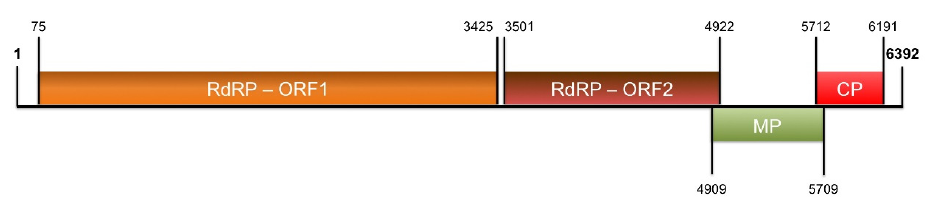
Figure 3. Sequencing analysis using ONT MinION. A graphical representation of the genome organization of ToBRFV isolate Tom-BA21. RdRp: RNA-dependent RNA polymerase; ORF: open reading frame; MP: movement protein; CP: coat protein.